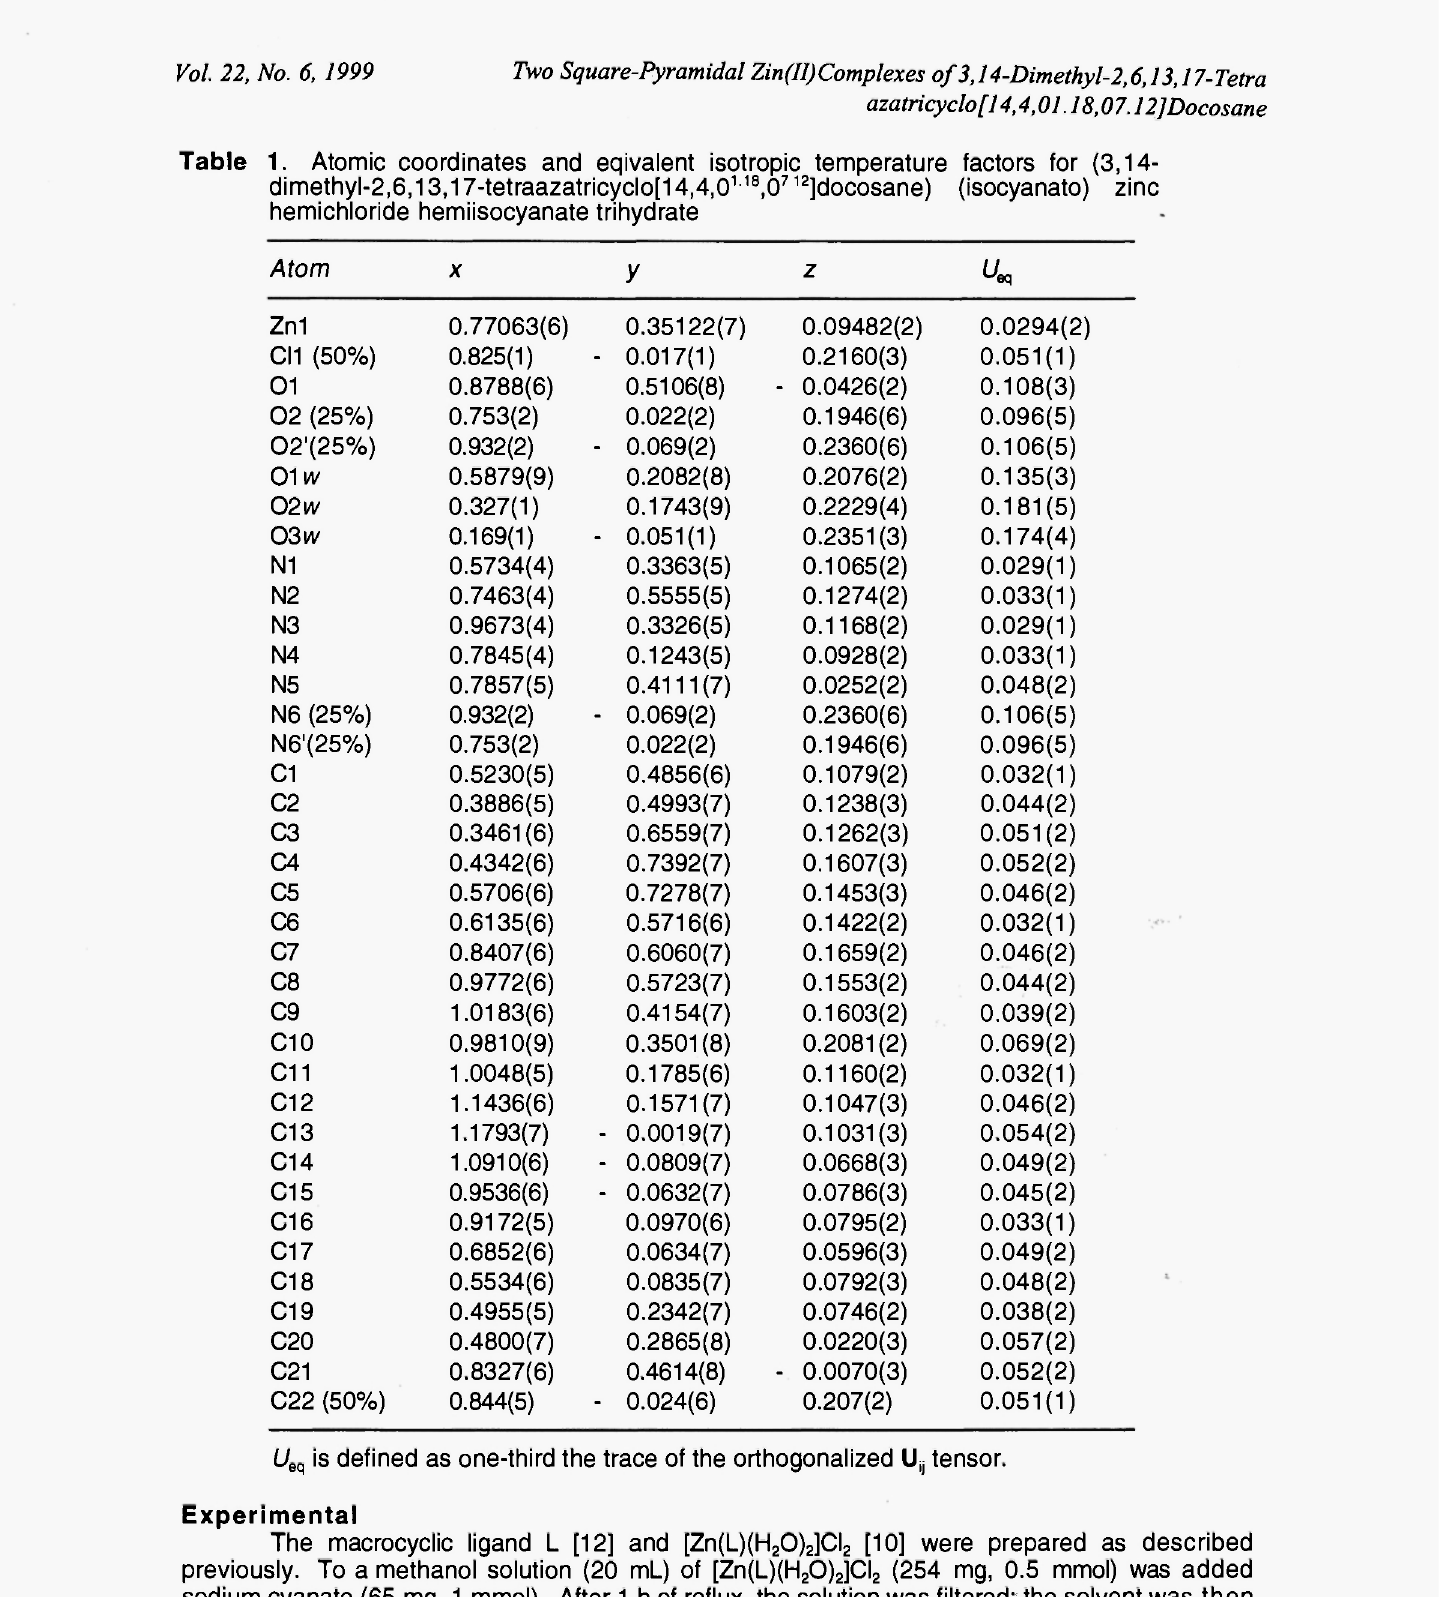
Table 1. Atomic coordinates and eqivalent isotropic temperature factors for (3,14- dimethyl-2,6,13,17-tetraazatricyclo[14,4,0 1 ^0 712 ]docosane) (isocyanato) zinc hemichloride hemiisocyanate